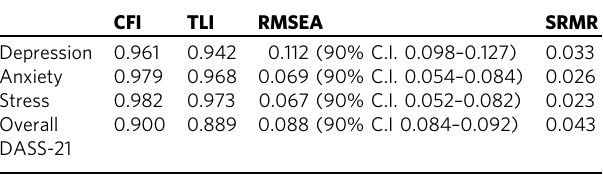
Table 4 DASS-21 and sub-scale item characteristics under graded response